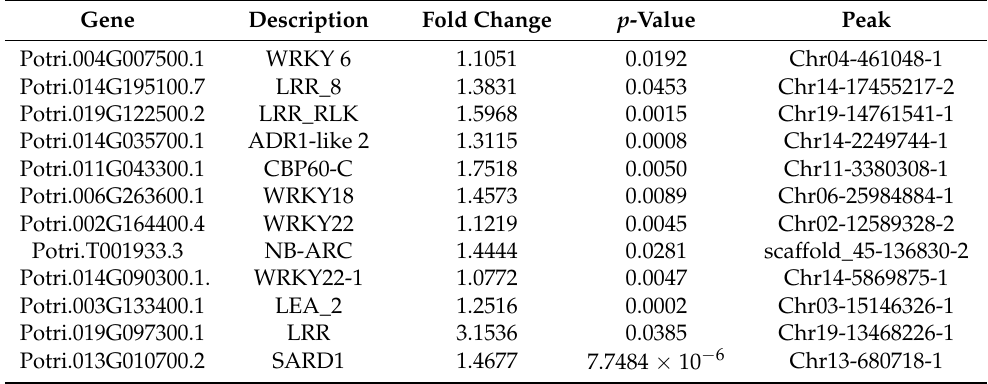
Table 1. Representative PsnWRKY70 DTGs were identified by RNA-seq and DAP-seq analysis. Gene Description Fold Change p -Value Peak Potri.004G007500.1 WRKY